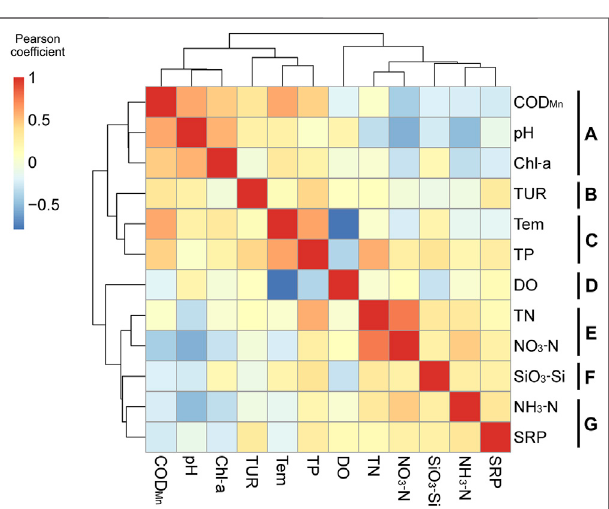
FIGURE 5 | The heatmap of Pearson correlations among the monitored physicochemical parameters in Gonghu Bay in the six sampling times. (The sample number of the Pearson correlation test is 90. DO, dissolved oxygen; SiO 3 -Si, active silicate; NO 3 -N, nitrate; NH 3 -N, ammonia; TN, total nitrogen;TP,totalphosphorus;Temp,watertemperature;Chla,chlorophylla; COD Mn , permanganate